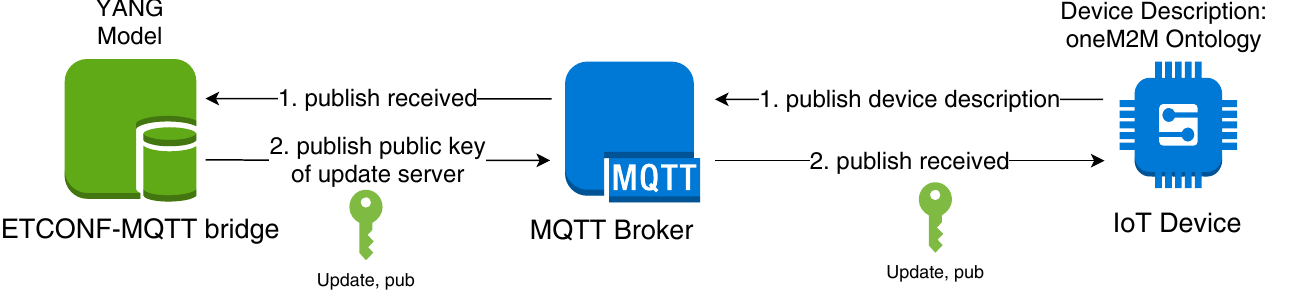
Figure 3. Bootstrap